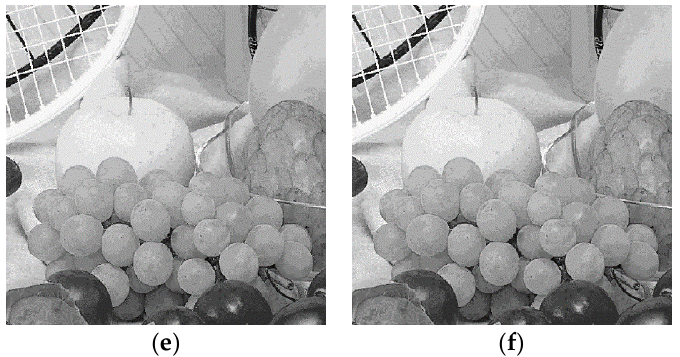
Figure 11. Visual investigation on Image Set 1 with quality factor 𝑄 = 5 : ( a ) input image; ( b ) JPEG decoded image; ( c ) ODBTC; ( d ) EDBTC; ( e ) DDBTC; and ( f ) DDBTC Gaussian method.